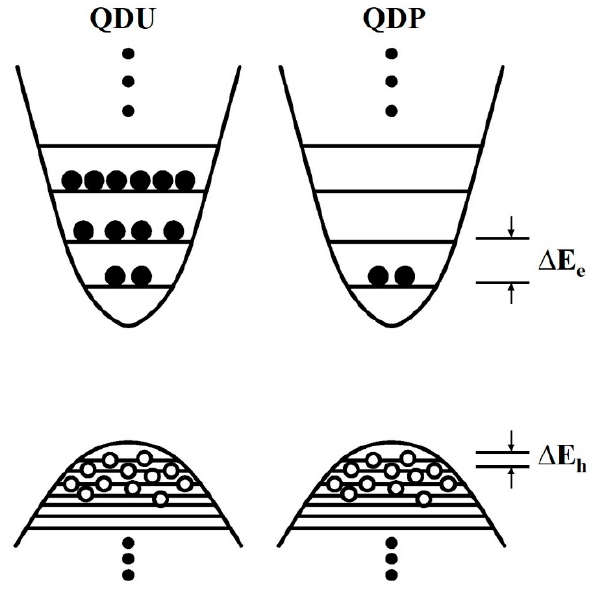
Figure 15. Schematic illustration of the discrete QD energy levels with different built-in carrier dis- tributions.